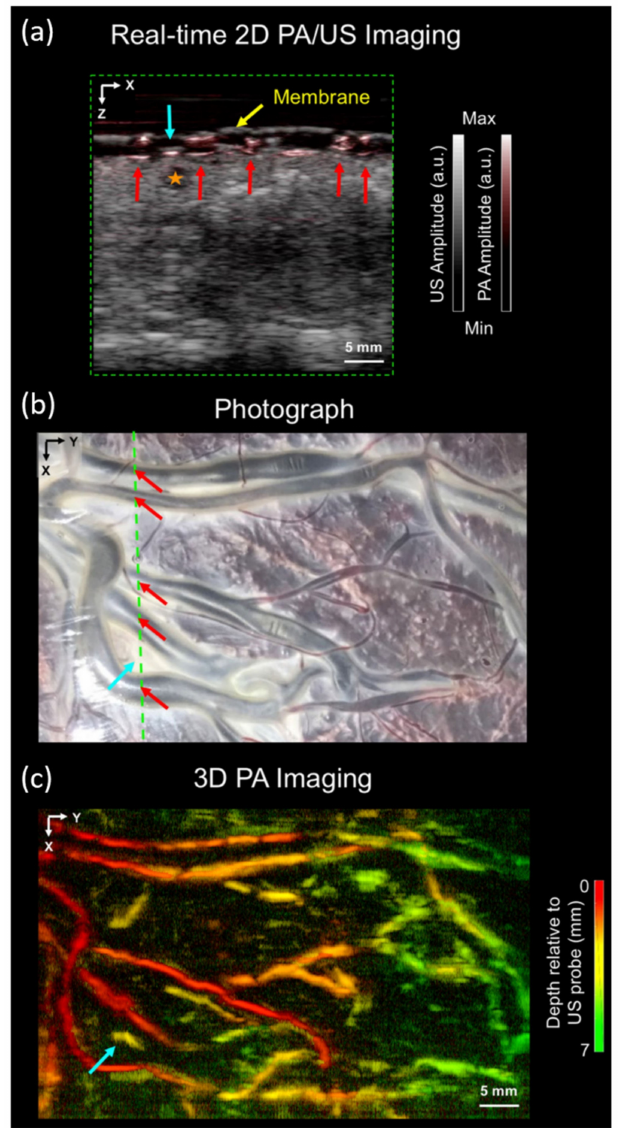
Figure 3. Wide-field PA-US images of the chorionic placental vasculature in an untreated part of a TTTS photocoagulated placenta. ( a ) 2D PA and US overlay image, acquired from a region corresponding to the green line in ( b ), which is a photograph of the imaged placenta. ( c ) 3D PA image displayed as a maximum intensity projection (MIP) of the reconstructed image volume. Reprinted from Ref.